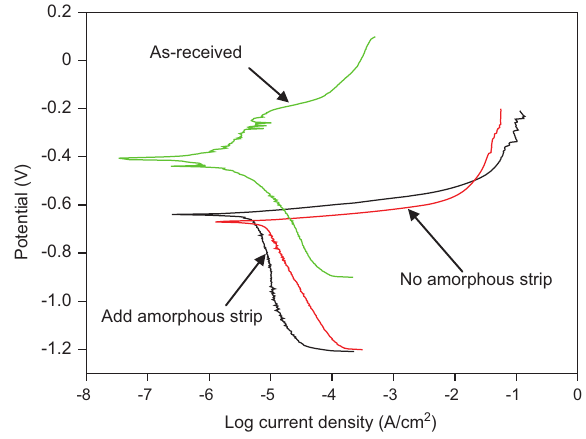
Figure 4 Microhardness distribution of the surface composite and the base metal.